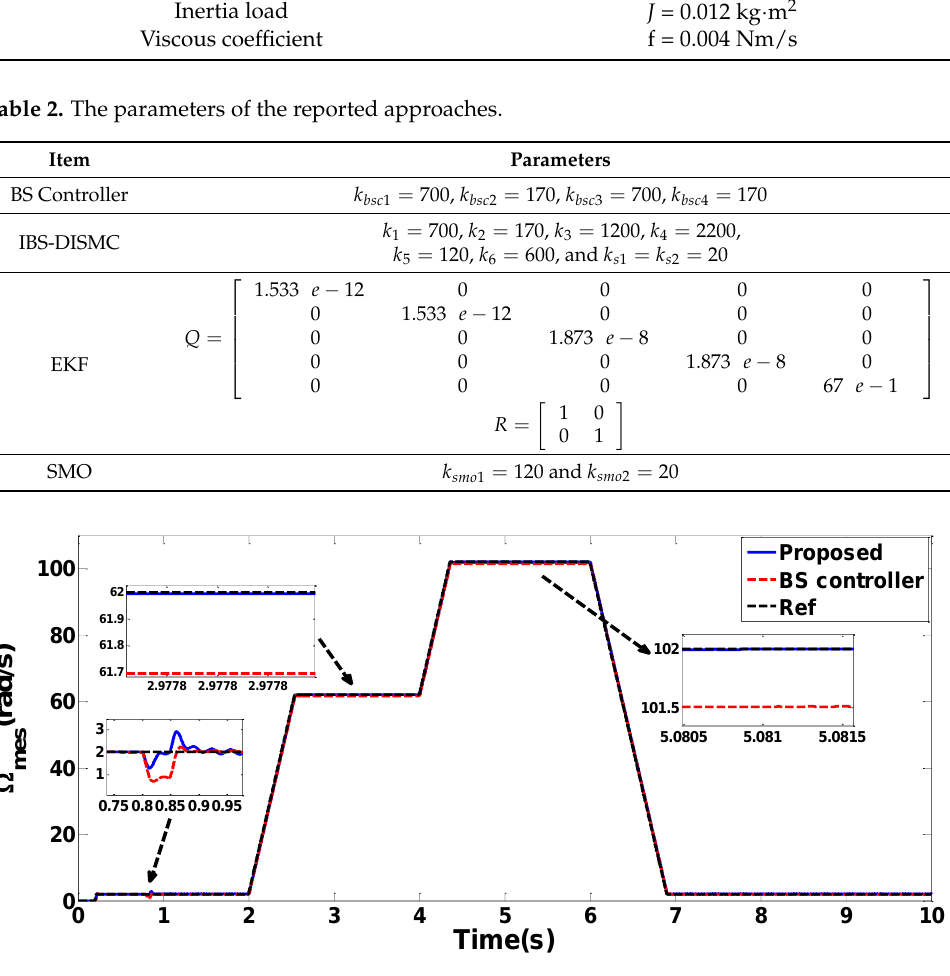
Figure 2. Velocity responses of the induction machine using BSC and IBS-DISMC.